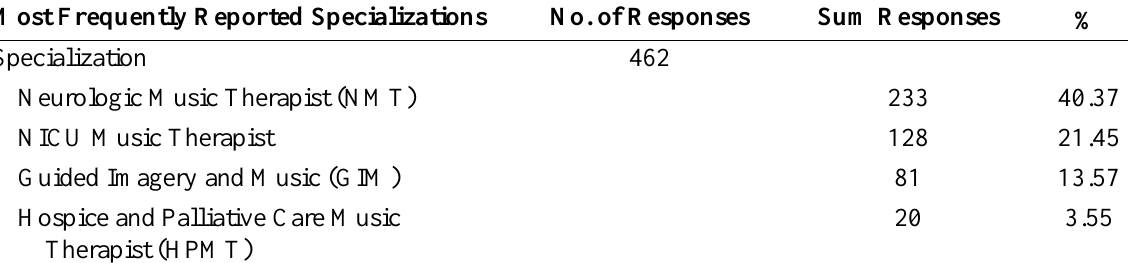
Most Frequently Reported Specializations